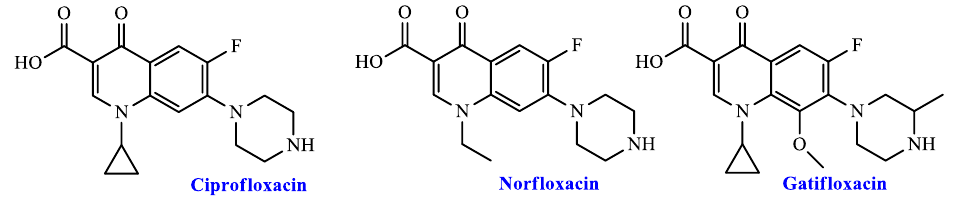
Figure 1. Chemical structures of some FDA approved marketed fluoroquinolone-based antibiotic